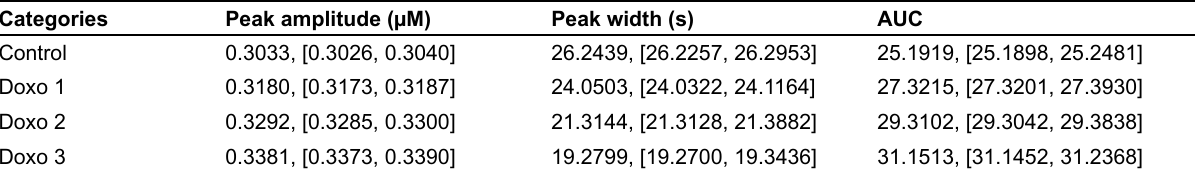
Table 2. Readout values and 90% CI for four different parametric conditions